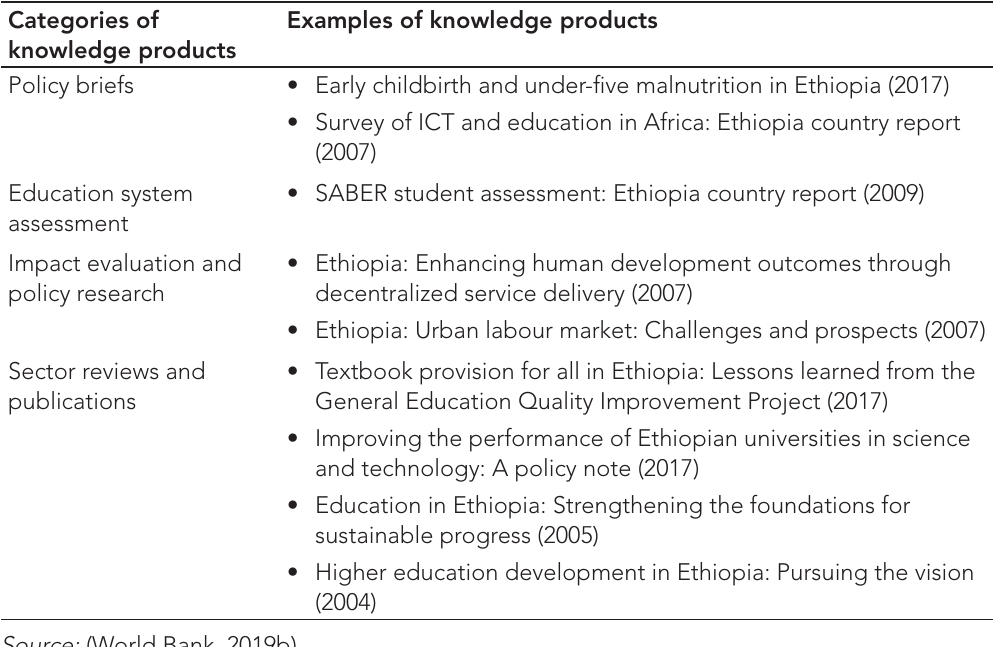
Table 1: World Bank’s knowledge aid to Ethiopia’s education